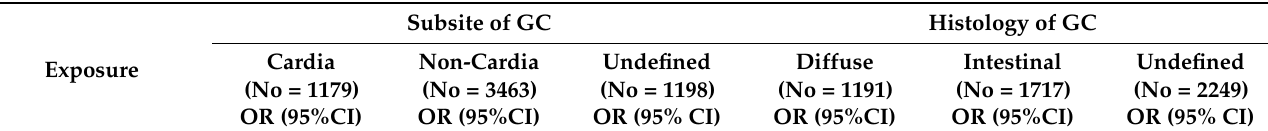
Table 3. Odds ratios (OR) and 95% confidence intervals (CI) of the association of yoghurt intake by approximate portions of yoghurt intake and GC subsites and histological types.